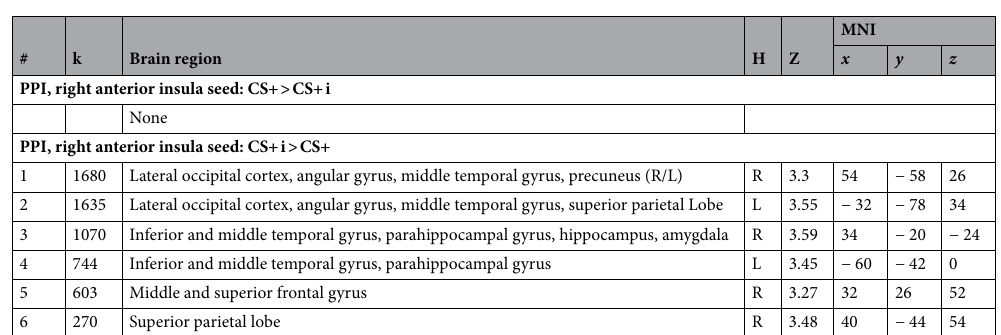
PPI, right anterior insula seed: CS+ > CS+